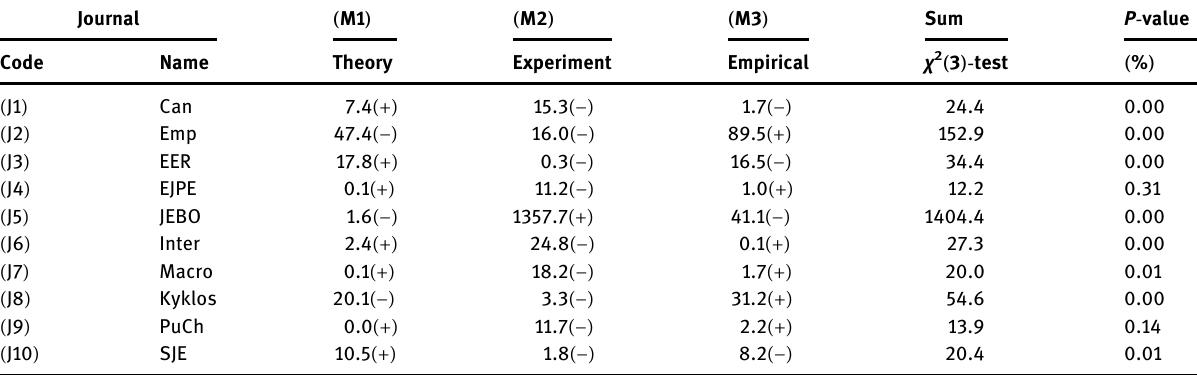
Table 5: The methodological pro fi le of the journals – χ 2 - scores for main groups